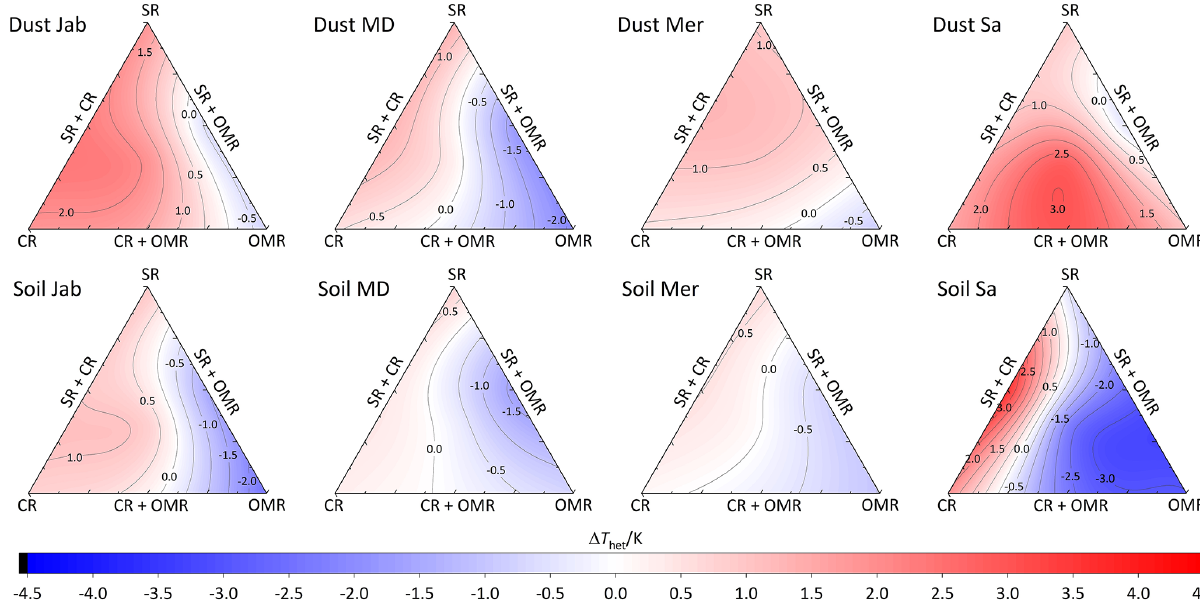
Figure 4. Effects of treatments in terms of (cid:49)T het(treatment-natural) for dust and soil samples at 5wt% concentration. SR: salt removed; CR: carbonate removed; OMR: organic matter removed; SR + CR: salt and carbonate removed; SR + OMR: salt and organic matter removed; SR + CR + OMR: salt-, carbonate-, and organics-removed treatments.